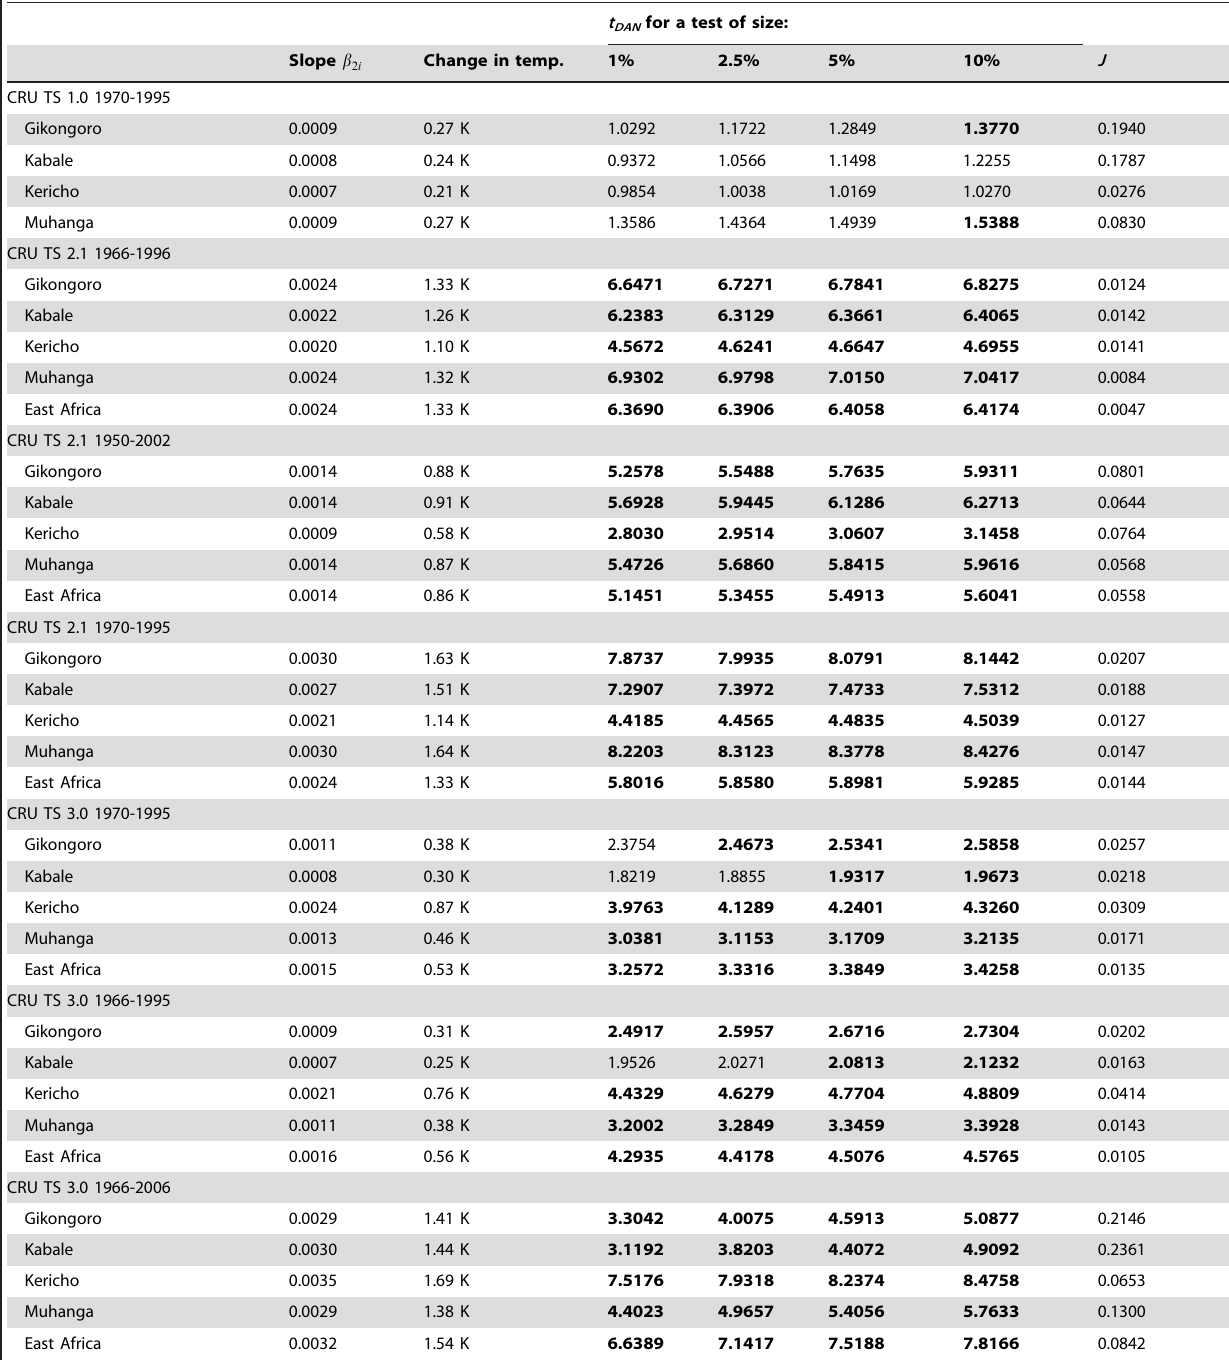
t DAN for a test of size: